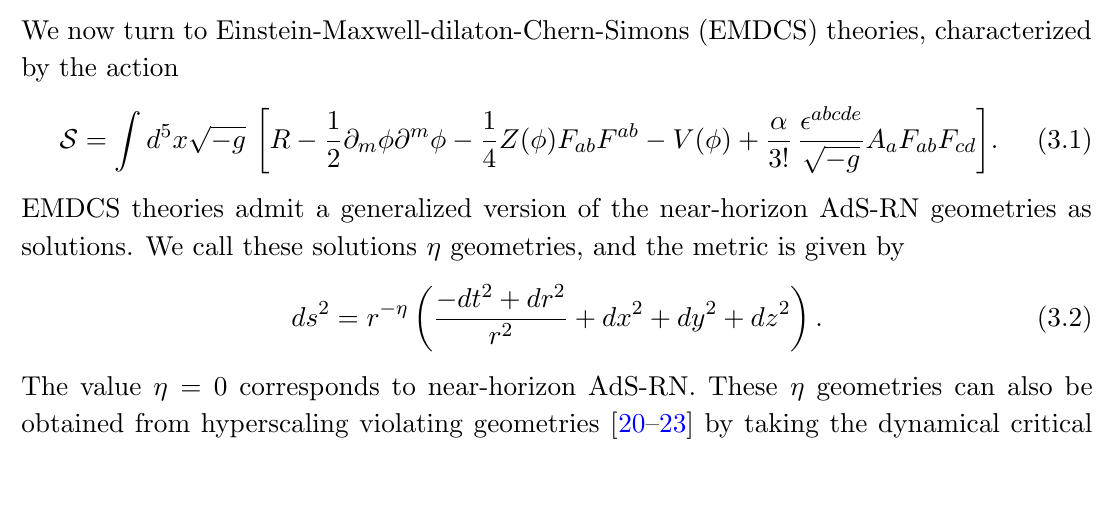
Figure 1. Transverse Channel. This is a region plot of the exponent (cid:23) ? lim ! ! 0 ! 2 (cid:23) ? k (cid:0) 1 . The upper shaded region, labeled Im[ (cid:27) ? where an instability occurs. The (cid:11) crit reproduces the result of [18]. In the blue region there is low energy spectral weight at nonzero momentum, and in the red region there is